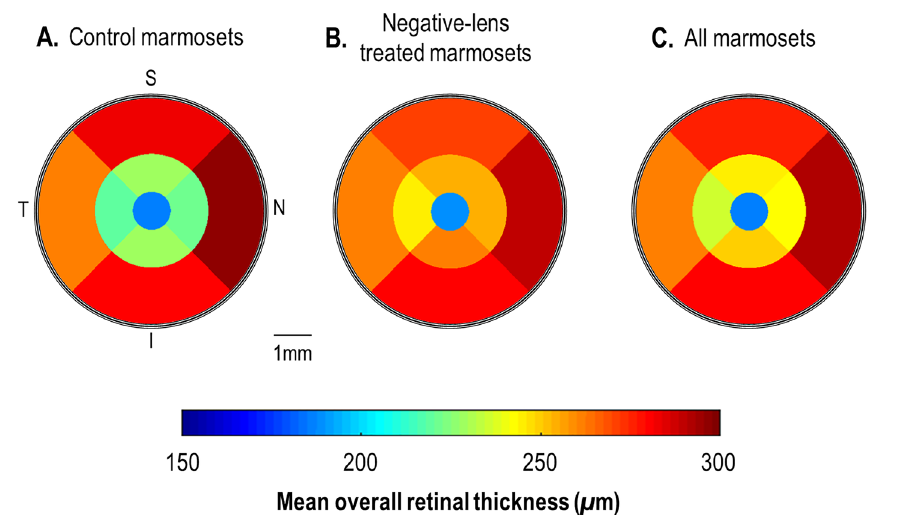
Figure 3. ETDRS color map summarizing the baseline mean overall retinal thickness measures for ( A ) control marmosets ( n = 5), ( B ) negative-lens treated marmosets ( n = 8) and ( C ) all marmosets in the two groups ( n = 13) treatment groups. Control and negative-lens treated marmosets had similar overall retinal thickness profile at baseline. S = Superior; T = Temporal; N = Nasal; and I =